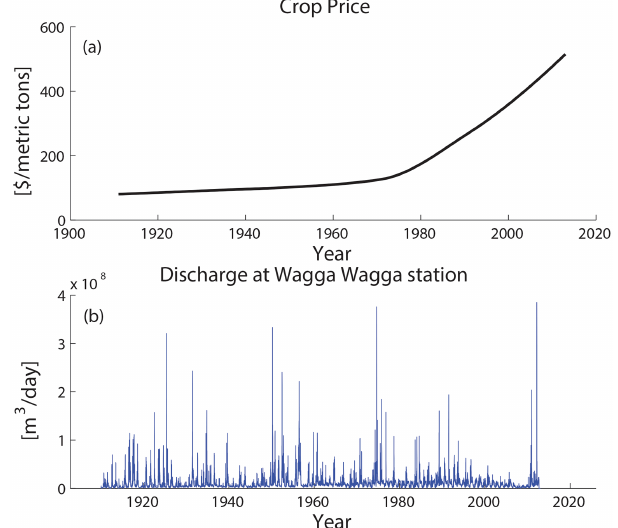
Figure 5. External drivers of the socio-hydrologic system: (a) world food (rice) prices (taken from the World Bank), and (b) measured discharge at Wagga Wagga.